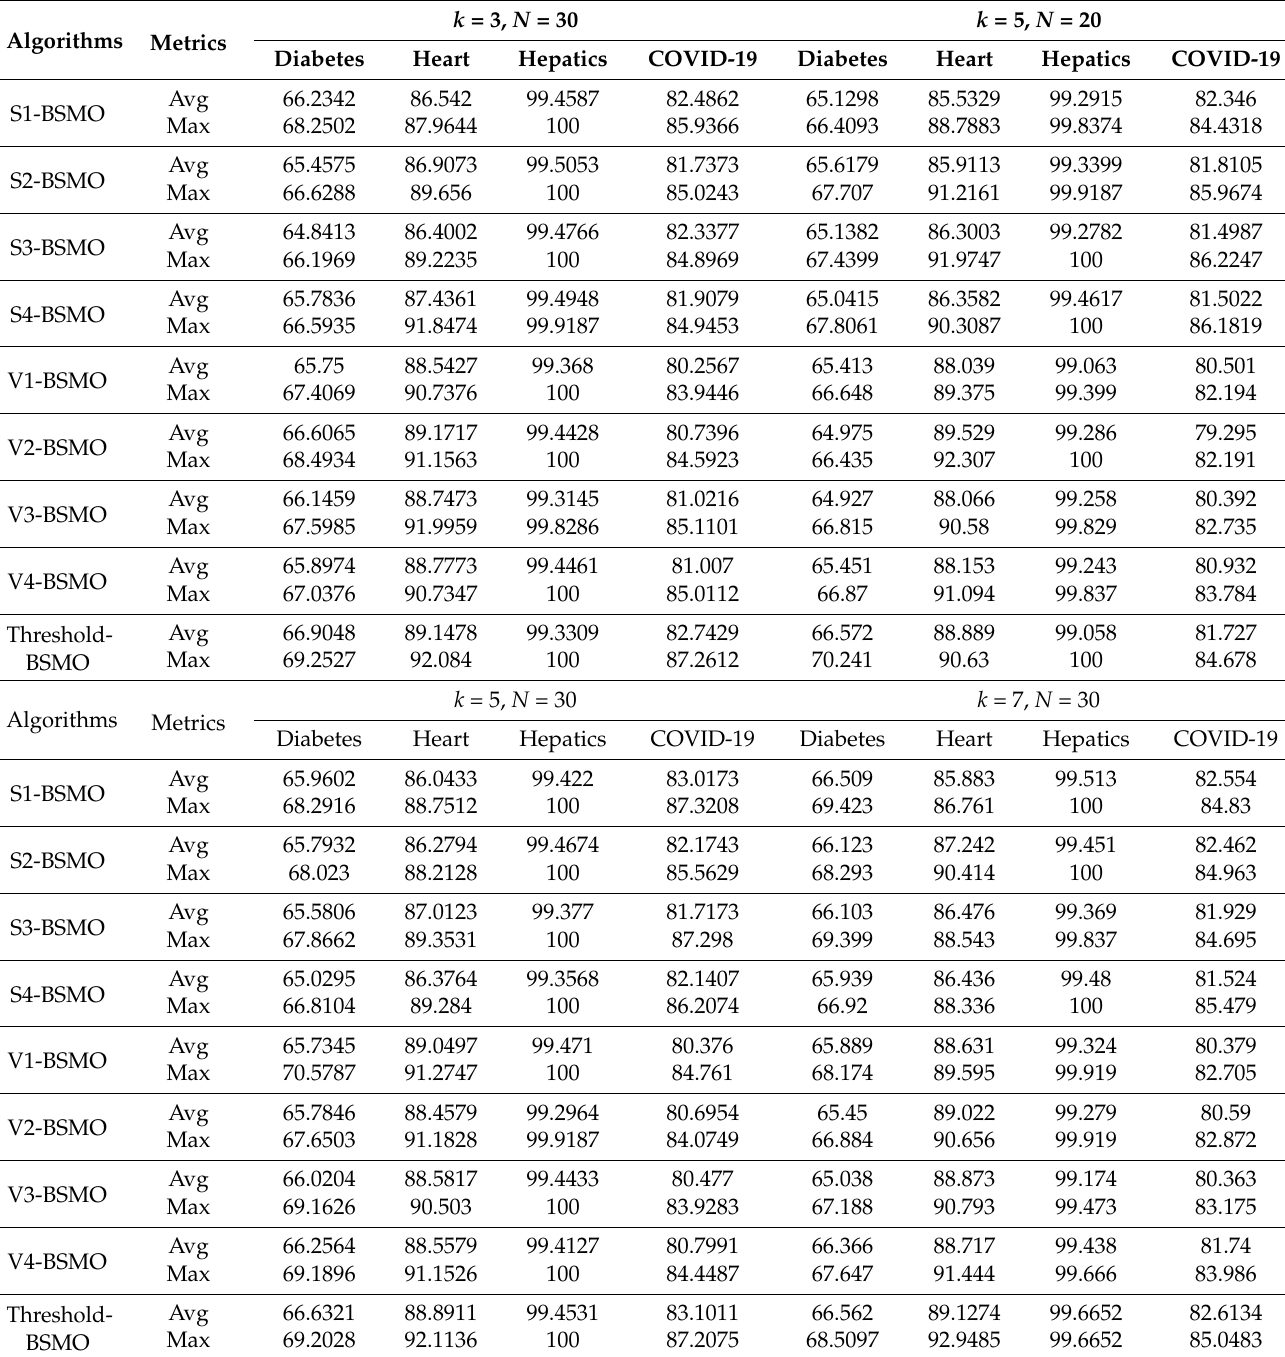
Table A6. Parameters setting of BSMO algorithm in terms of specificity